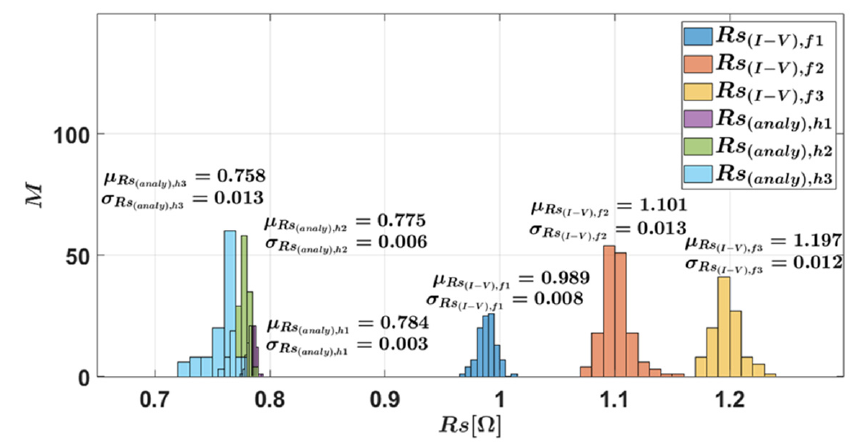
Figure 23. Histograms of R s resistances. The histograms of the residuals are plotted in Figure 24. The fault can be detected because for each case, (cid:101) > ε Rs th . The severity levels can also be estimated with a good accuracy, as shown in Table